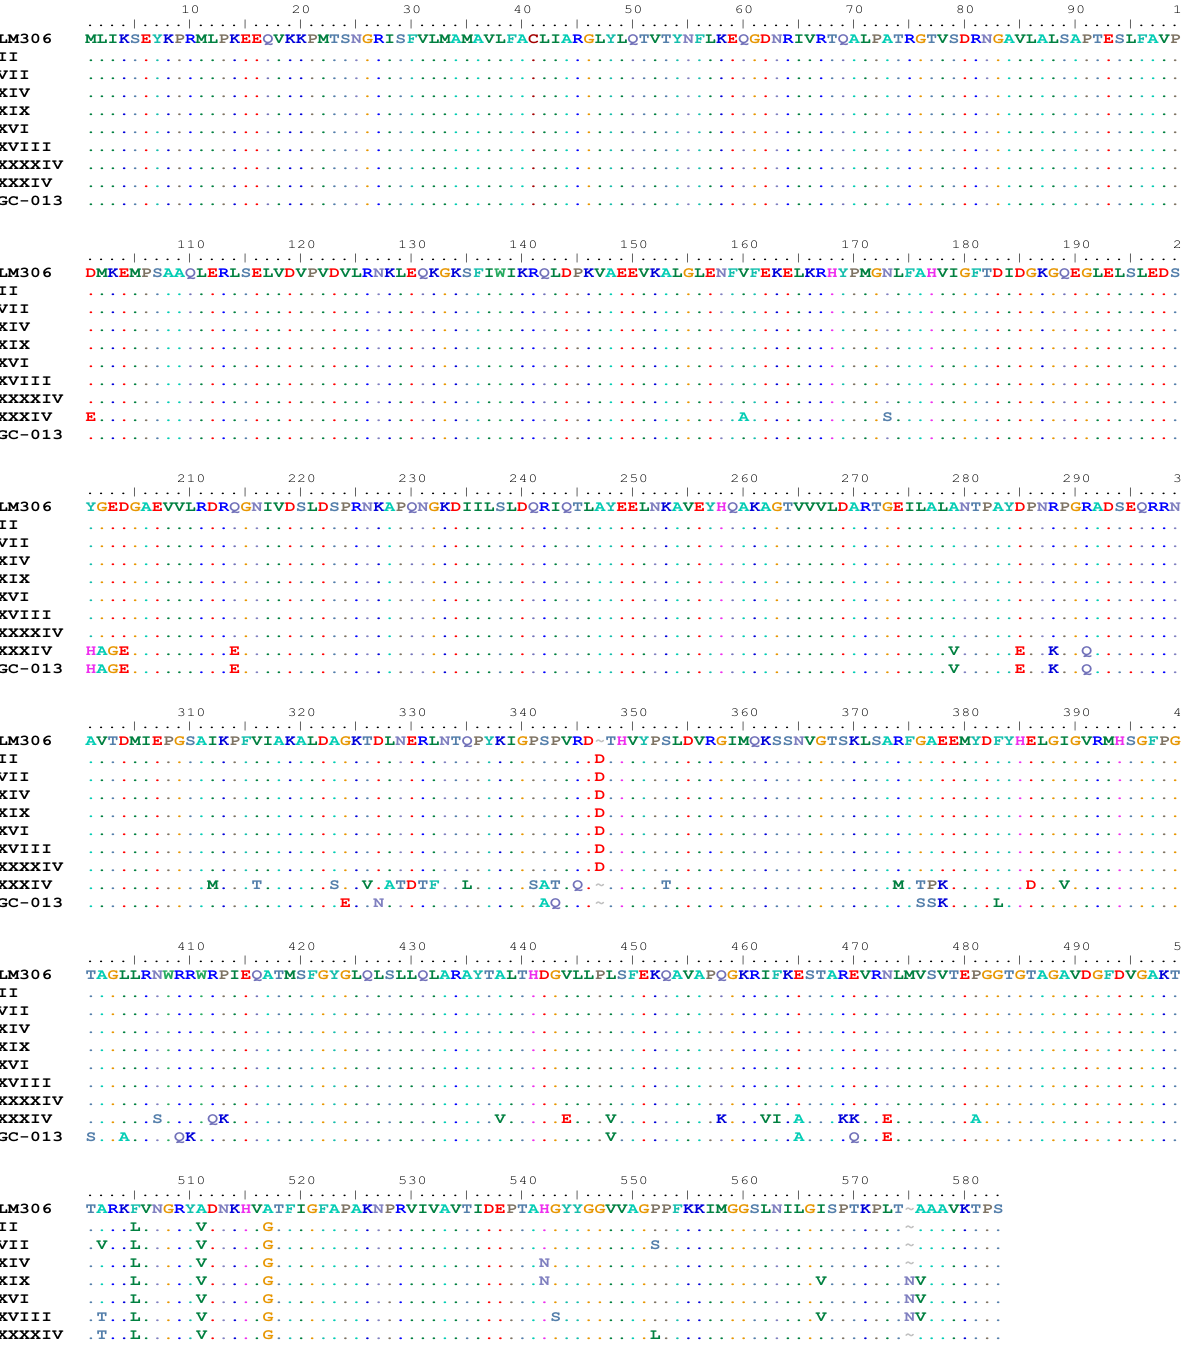
Figure 1. The amino acid sequence alignments of different PBP2 patterns of 9 N . gonorrhoeae isolates including nonmosaic PBP2 pattern II, VII, XIV, XIX, XVI, XVIII, XXXXIV, mosaic XXXIV, and new mosaic pattern (GC-013) were compared with the wild type PBP2 of N. gonorrhoeae strain LM306 (GenBank accession no.